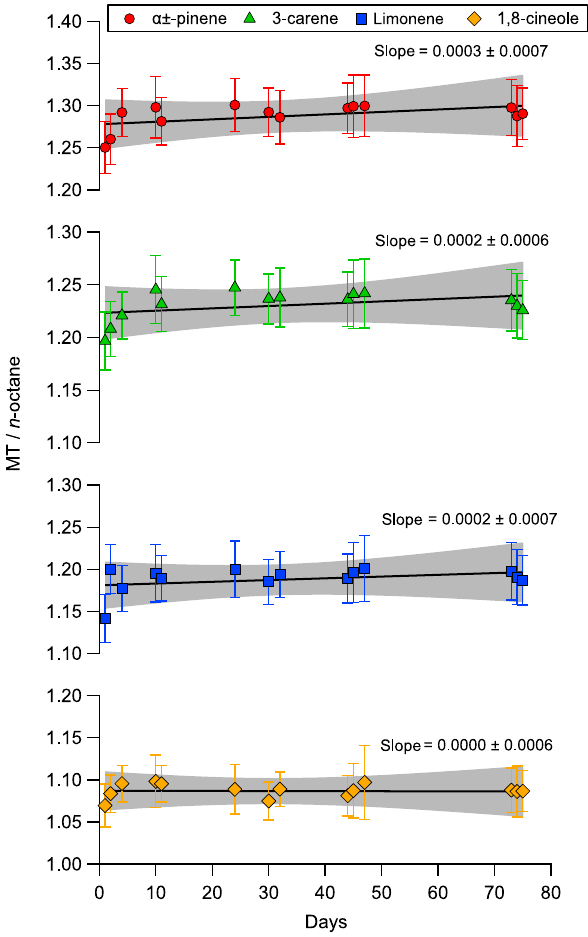
Figure 5. The short-term stability of reference PRM (mixture BB) at nominally 2nmolmol − 1 compared as a ratio of the area of each monoterpene normalised relative to the n -octane internal standard. Error bars are included to account for the relative standard deviation of the mean ( k = 2). The solid lines show the results of a linear least squares fitting routine with the shaded area showing the confidence interval (95%) of the